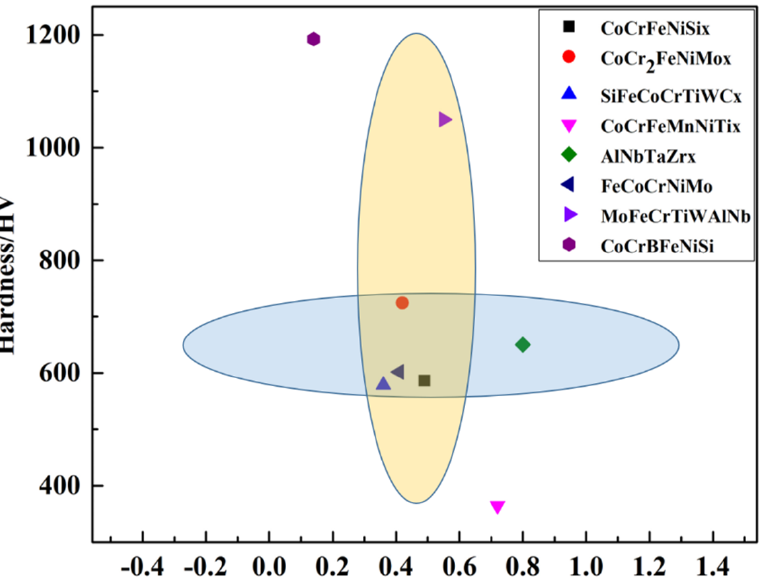
Figure 7. Hardness and friction coefficient of HEA coatings for laser cladding technology.